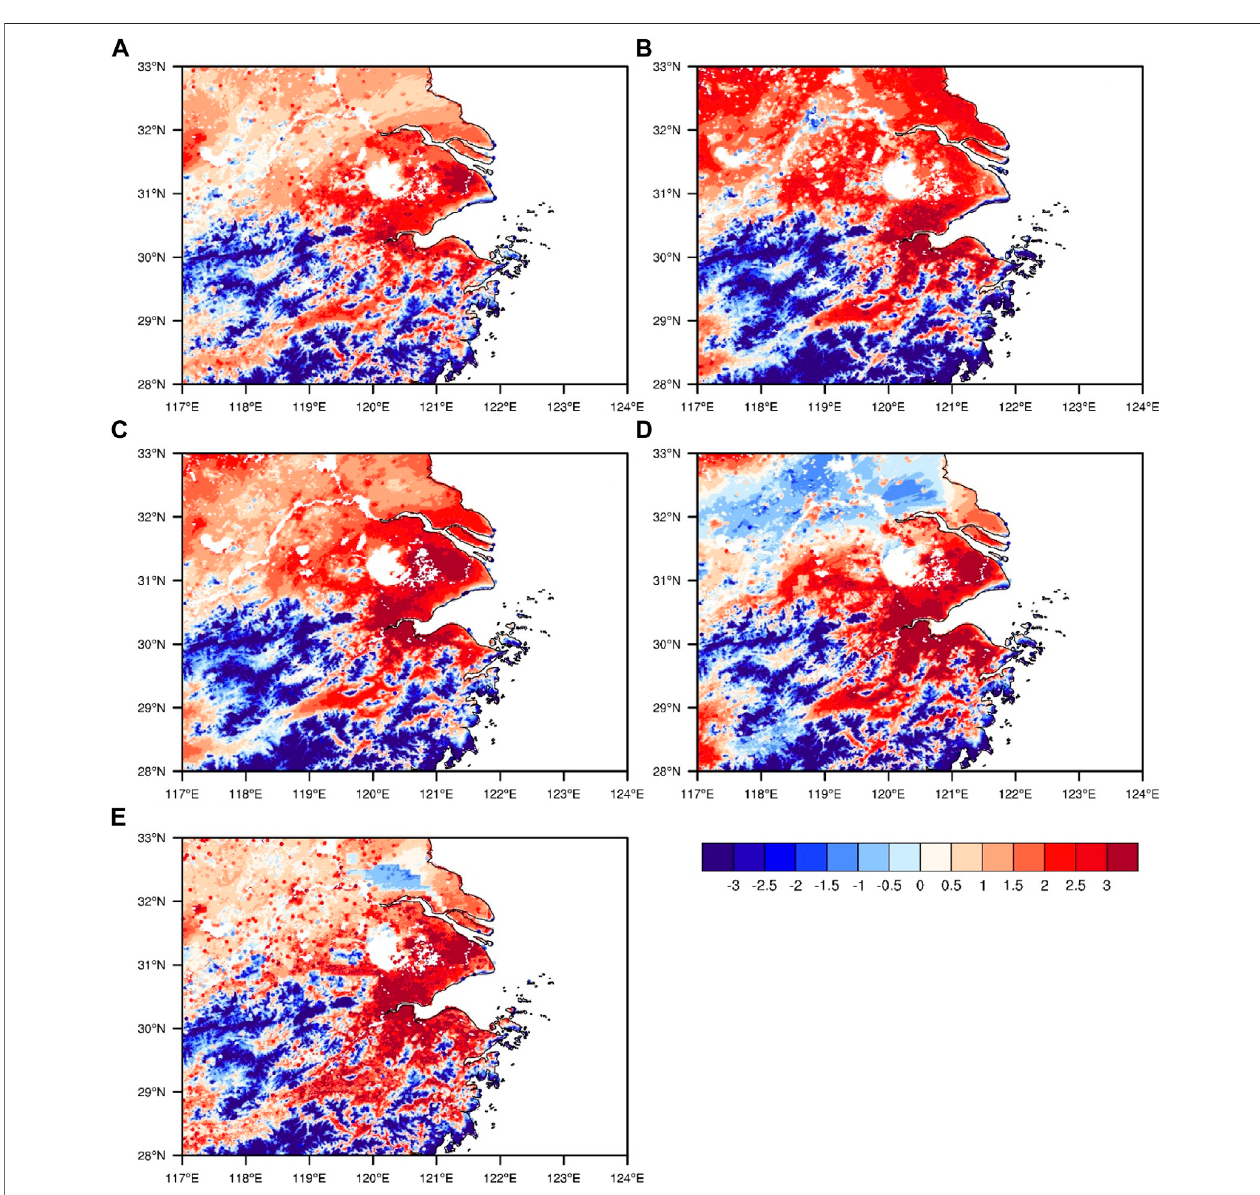
FIGURE 3 | Multi-day averaged daily maximum surface air temperature anomalies ( ° C) in eastern China during the 2013 summer from fi ve individual experiments with (A) 5TD, (B) CLM4, (C) Noah, (D) Noah-MP and (E) RUC land surface schemes.